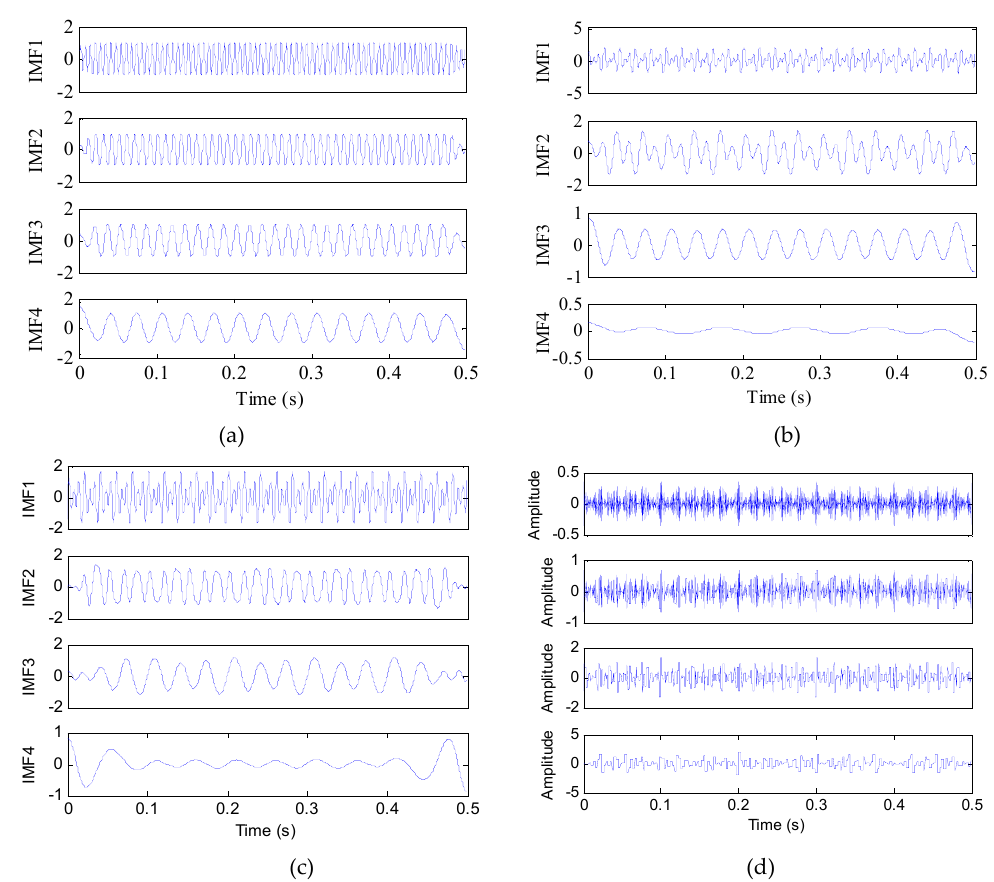
Two-dimensional and ( b ) three-dimensional. and ( b ) three-dimensional. Appl. Sci. 2020 , 10 , x FOR PEER REVIEW